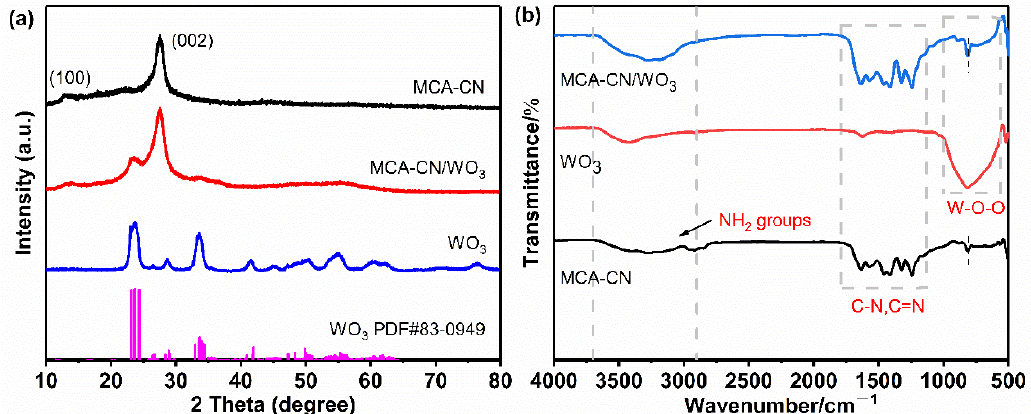
Figure 3. ( a ) XRD patterns of MCA-CN and MCA-CN/WO 3 and ( b ) FTIR patterns of MCA-CN, WO 3 and MCA-CN/WO 3 .